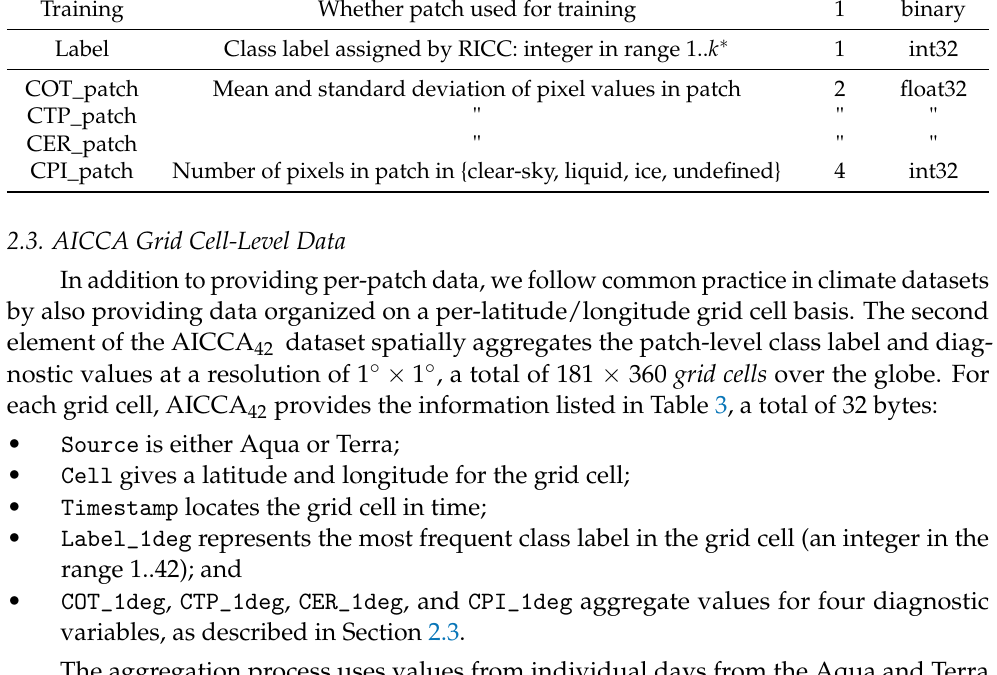
Table 2. Information provided in AICCA for each 128 × 128 pixel ocean-cloud patch: metadata that locate the patch in space and time, and indicate whether the patch was used to train RICC; a cloud class label computed by RICC; and a set of diagnostic quantities obtained by aggregating MODIS data over all pixels in the patch. A quotation mark indicates a repetition. Variables Description Values Type Swath Identifier for source MODIS swath 1 float32 Location Geolocation index for the upper left corner of patch 2 float32 Timestamp Time of observation 1 float32 Training Whether patch used for training 1